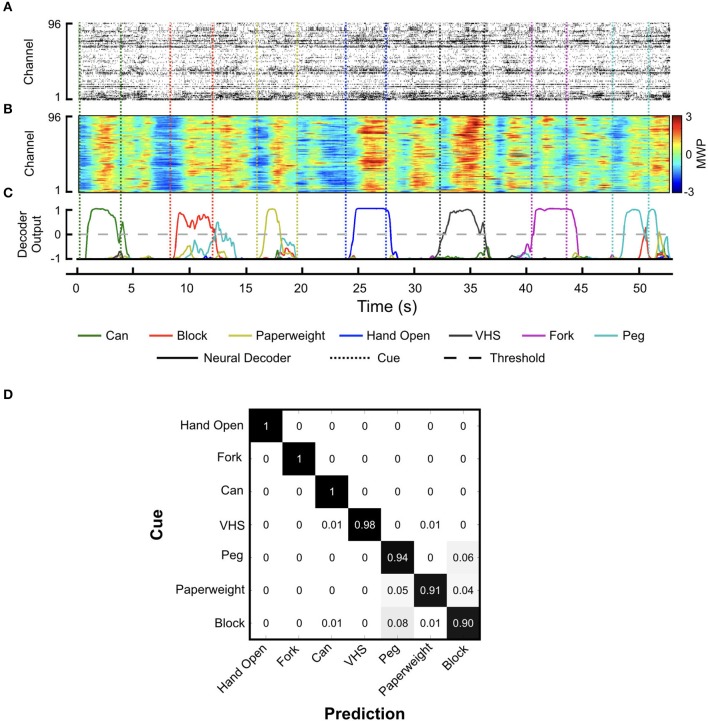
Neural decoder training. Representative plots showing (A) threshold crossing raster plot, (B) the corresponding MWP activity across all channels of the MEA, and (C) neural decoder output as the participant attempts the seven cued hand movements. Solid lines indicate neural decoder output and dotted lines indicate the cue start and stop times. Of the seven possible hand movement states that can be predicted by the decoder, the output score from the one with the highest amplitude greater than zero was used to turn on/off the stimulation; (D) Confusion matrix showing the decoder response probability for each movement cue.